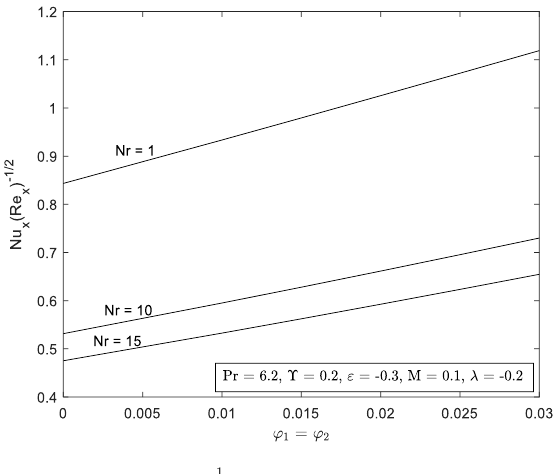
Figure 17. 𝑁𝑢 𝒙 (𝑅𝑒 𝒙 ) − Figure 17. Nu x ( Re x ) −